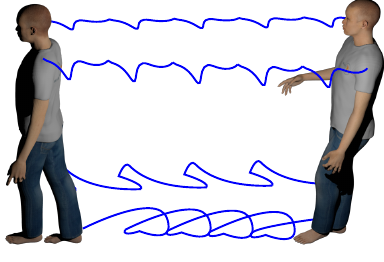
Figure 9. Walking Pattern: Foot and knee trajectory has a highly non-linear pattern. Head and shoulder trajectories appear to be more linear